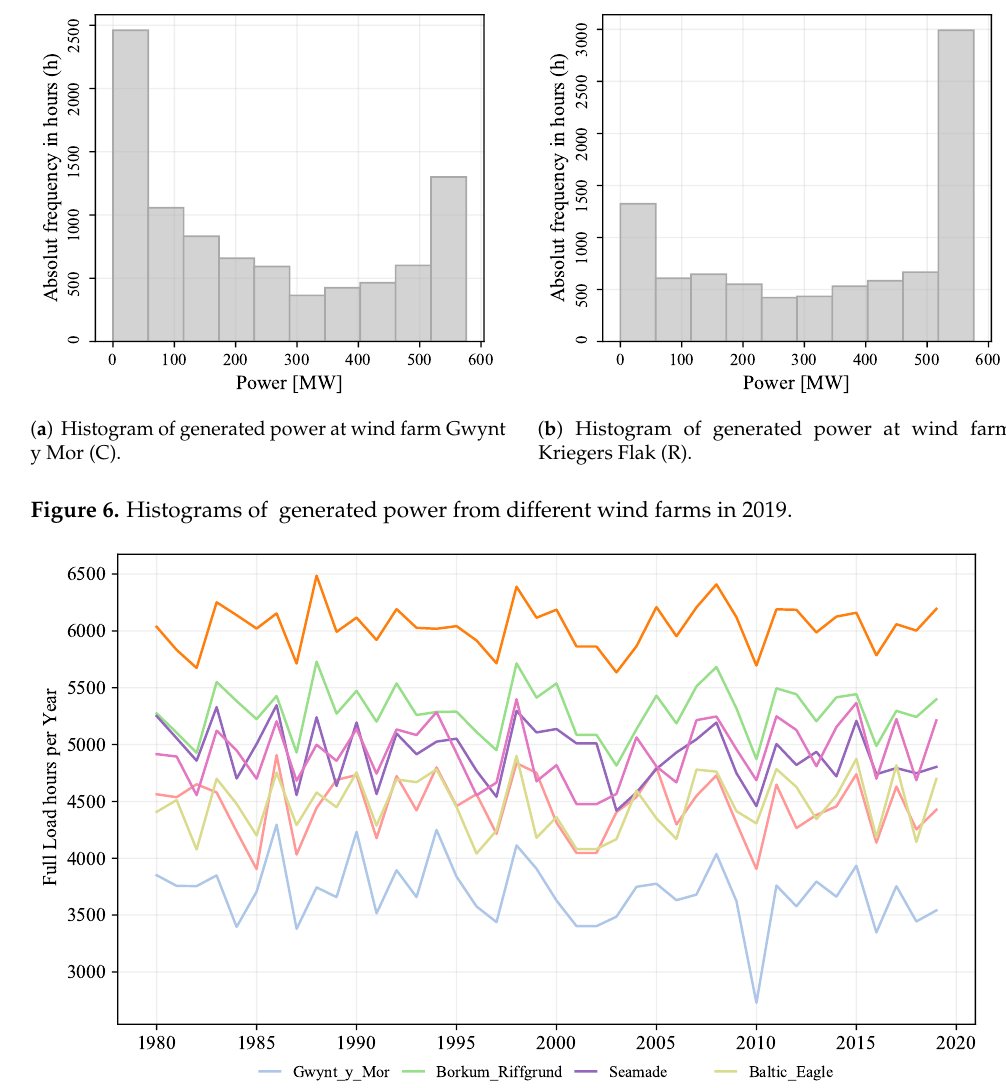
Figure 7. Full-load hours of selected wind farms from 1980 to 2019. Every line illustrates the yearly full-load hours of one wind